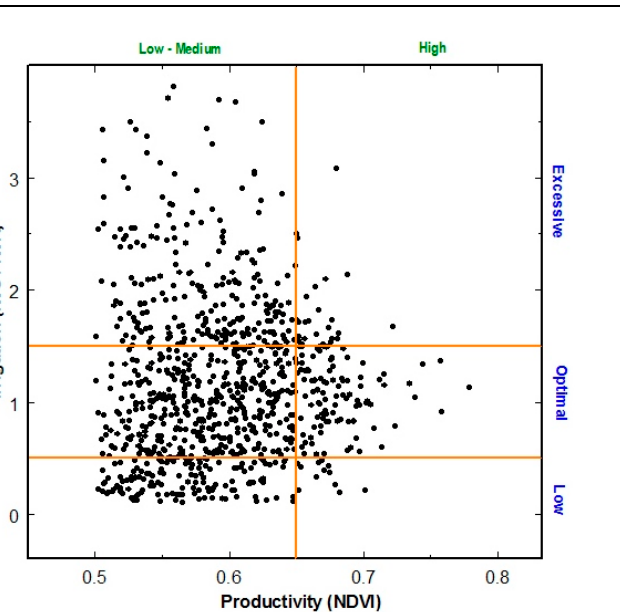
Figure 10. Diagram showing low-medium and high pasture productivity (NDVI) for Summer 2015 – 2016 (x-axis) against categories associated with low (sub), optimal, and excessive (supra) classes of IWS:IWR ratio